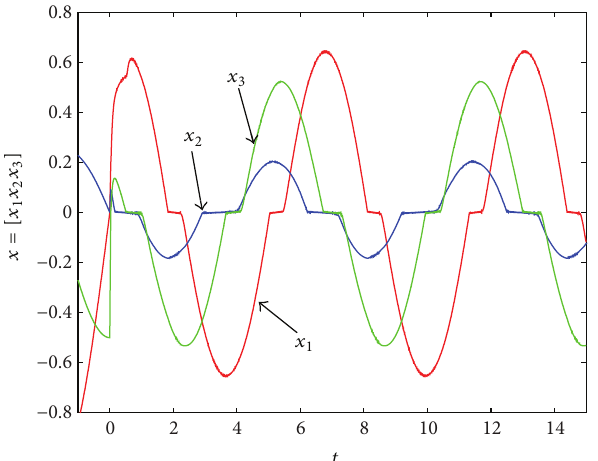
Figure 1: Time-domain behavior of the state variables 𝑥 1 , 𝑥 2 , and 𝑥 3 when 𝐼(𝑡) = (15 sin 𝑡,10 cos 𝑡,15 cos 𝑡) 𝑇 .